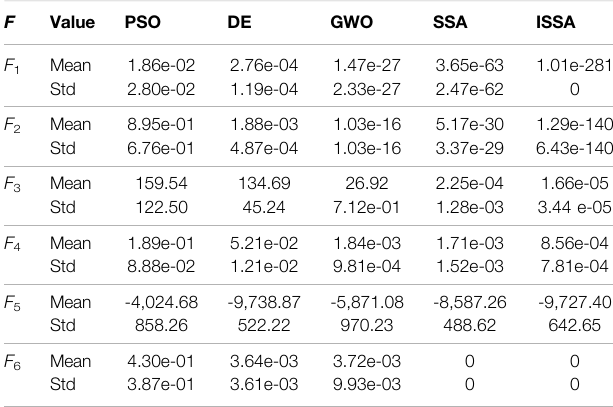
TABLE 3 | Optimization results of algorithms (D =